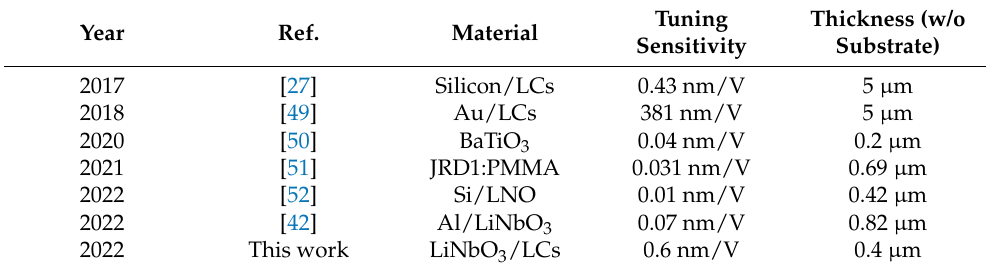
Figure 8. ( a ) The transmission spectra of the integrated LiNbO 3 metasurface for different applied bias voltages. The asymmetric cylinder: h = 400 nm, r = 370 nm, t = 200 nm, w = 500 nm, θ = 0 ◦ . ( b ) The phase spectrum of the integrated LiNbO 3 metasurface for different applied bias voltages at the operating wavelength of 1521 nm. The voltages increase from 0 to 70 V. Inset: Electric and magnetic field distributions of the integrated metasurface, respectively. The black arrows correspond to the electric field vectors, and the brown arrows correspond to the magnetic field vectors. ( c ) The transmission spectra of the integrated LiNbO 3 metasurface for different kinds of refractive indices. Inset: Electric field distributions of the LiNbO 3 cylinder integrated with and without LCs at 70 V, respectively. ( d ) The transmission spectra of the integrated metasurface with symmetric cylinders for Table 1. Comparison of our results with the tuning sensitivity of different